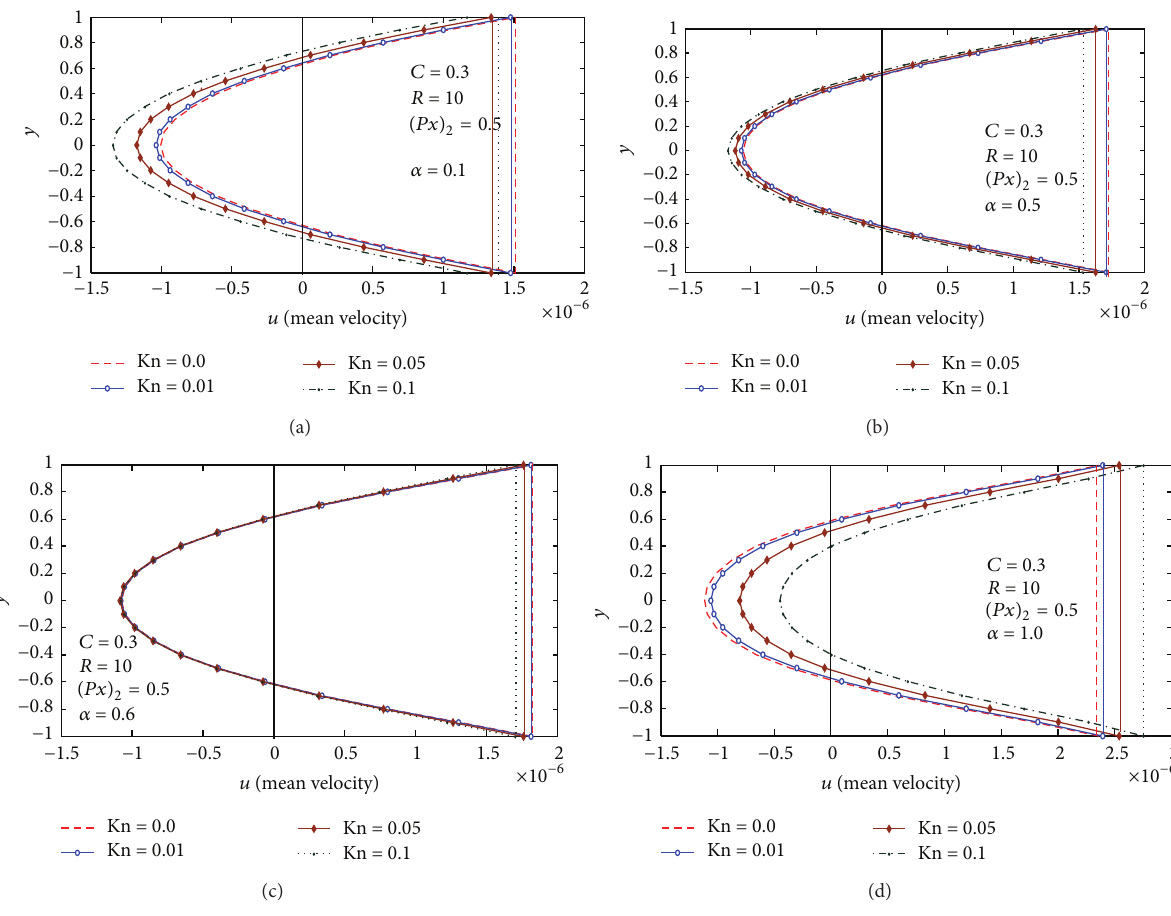
Figure 6: (a) Mean velocity distribution at 𝛼 = 0.1 , (𝜕𝑝/𝜕𝑥) 2 = 0 .5 , and 𝐶 = 0.3 . (b) Mean velocity distribution at 𝛼 = 0.5 , (𝜕𝑝/𝜕𝑥) 2 = 0 .5 , and 𝐶 = 0.3 . (c) Mean velocity distribution at 𝛼 = 0.6 , (𝜕𝑝/𝜕𝑥) 2 = 0 .5 , and 𝐶 = 0.3 . (d) Mean velocity distribution at 𝛼 = 1.0 , (𝜕𝑝/𝜕𝑥) 2 = 0 .5 , and 𝐶 = 0.3 .